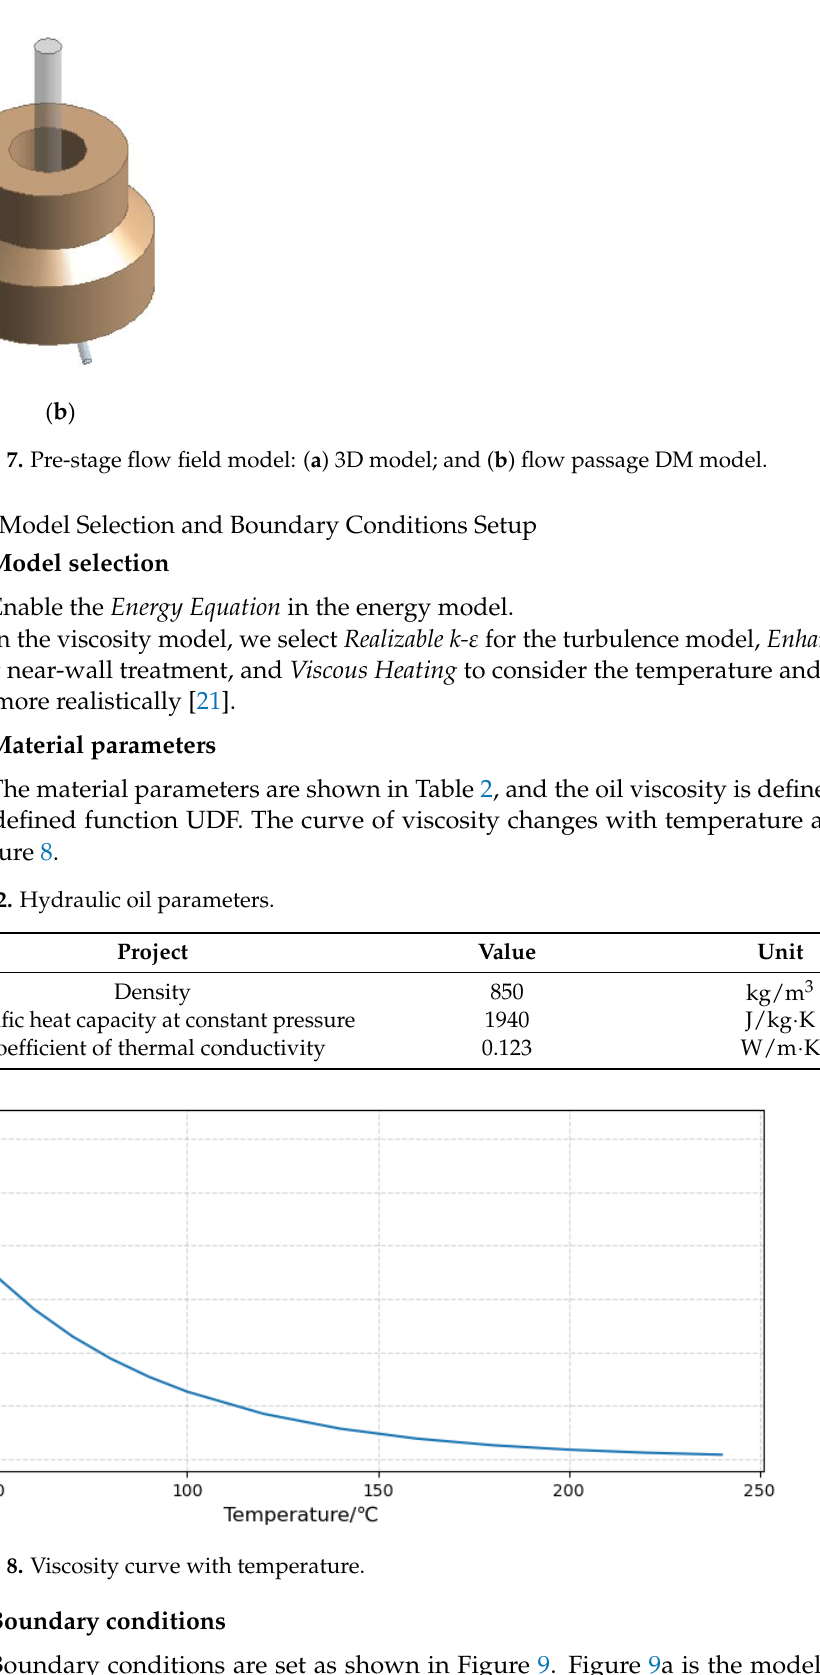
( b ) Figure 9. Schematic diagram of setting boundary conditions: ( a ) Block-load model; and ( b ) Con- nected model. Inlet: adopt pressure inlet , pressure 𝑝 𝑠 is 21 MPa, and inlet oil temperature is 300 K. Outlet: pressure outlet is used. The oil return pressure 𝑝 𝑡 is set to 0.5 MPa. Wall surface: slip-free fixed-wall surface. 3.1.3. Meshing As an approximate solution method, the accuracy of numerical simulation results is affected by many factors, such as mesh quality and mesh quantity. It is generally believed that the more the number of grids, the higher the accuracy of the solution. At the same time, the rapid increase in computing scale and storage space leads to a decrease in com- puting efficiency. Therefore, it is necessary to select a reasonable number of grids to im- prove the computational efficiency on the premise of ensuring the computational results [22]. According to the analysis in Section 2, the impact jet section of oil in the flow field of the pre-stage is very important, so the relevant area adopts an encrypted mesh, as shown in Figure 10a. The flow at other positions, such as the oil inlet end, oil return end, and the remote end of the receiving channel, is not violent, so the grid size adopts the system